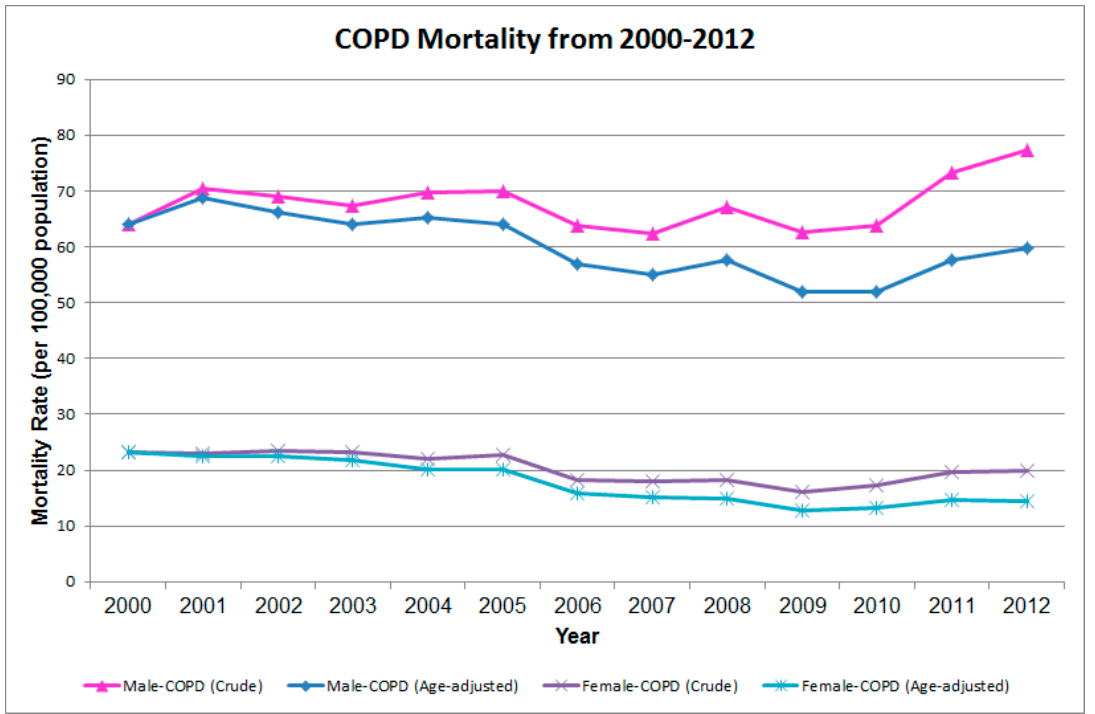
Figure 1. Temporal trend of crude and age-adjusted mortality (aged 40 years or older) of chronic obstructive pulmonary disease (COPD) in Taiwan from 2000–2012.